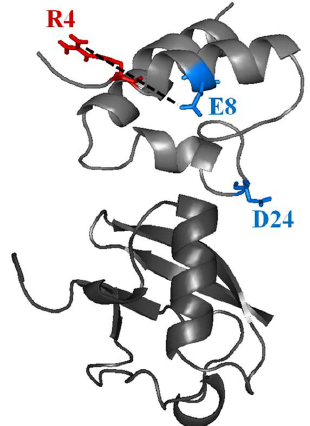
Figure 9. Location of the perturbed polar and neutral residues in the interaction of CUBAN domain with NEDD8. Residues R4, E8 and D24 are shown. The dotted line indicates a possible intra molecular hydrogen bond.